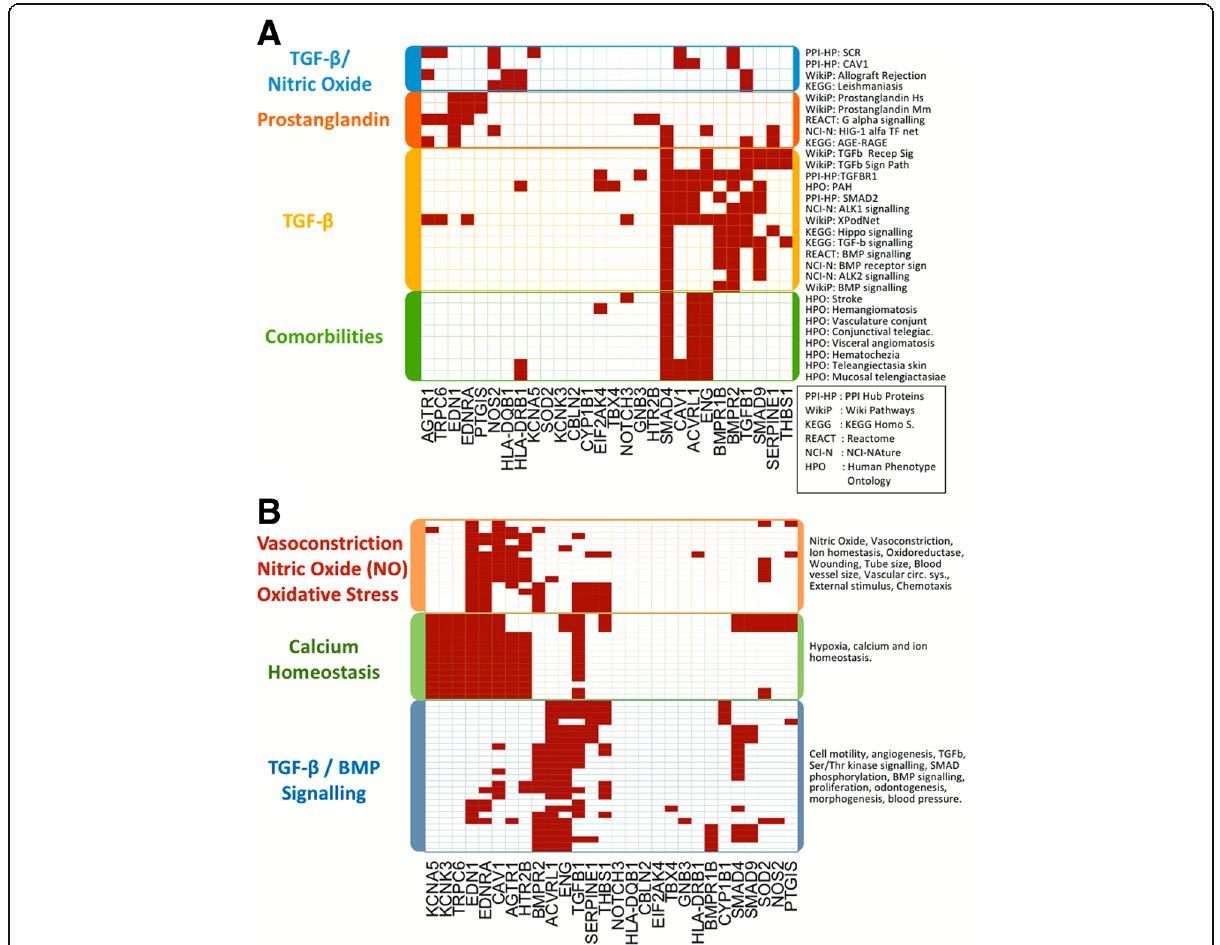
Fig. 4 Functional analysis of the genes found genetically altered in PAH. a Pathways and comorbilities. b Gene ontology terms. Only the genes with annotations in these terms are included in the mapping. Color figure can be viewed in the online